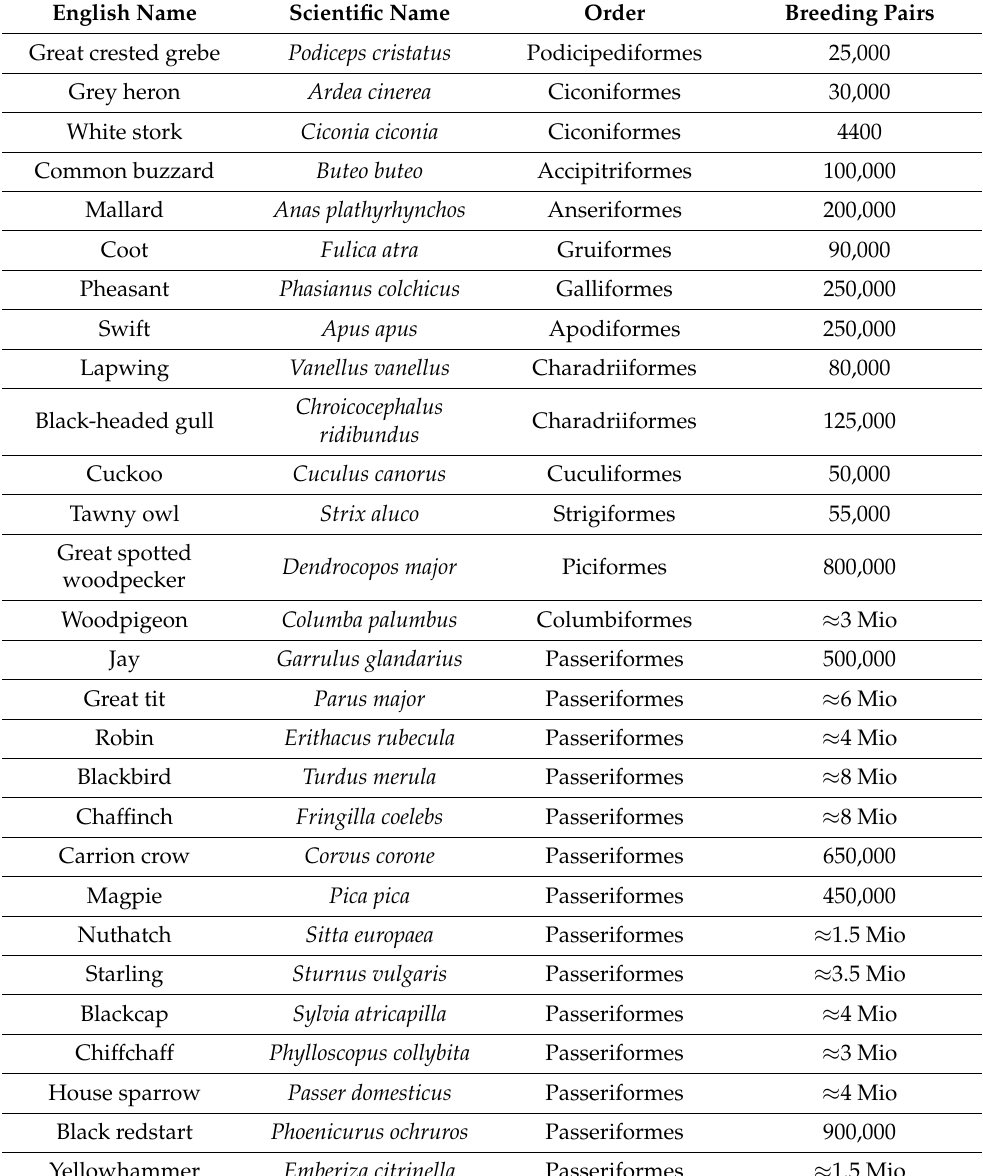
Table A1. Bird species used in this study. The breeding pairs are only rough estimates based on the German breeding bird atlas